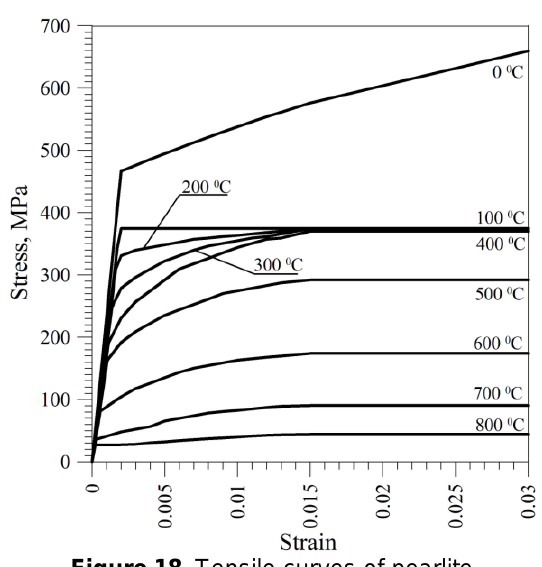
Figure 18. Tensile curves of